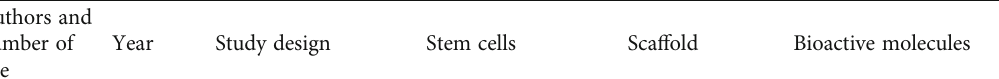
Table 2: In vivo and in vitro studies